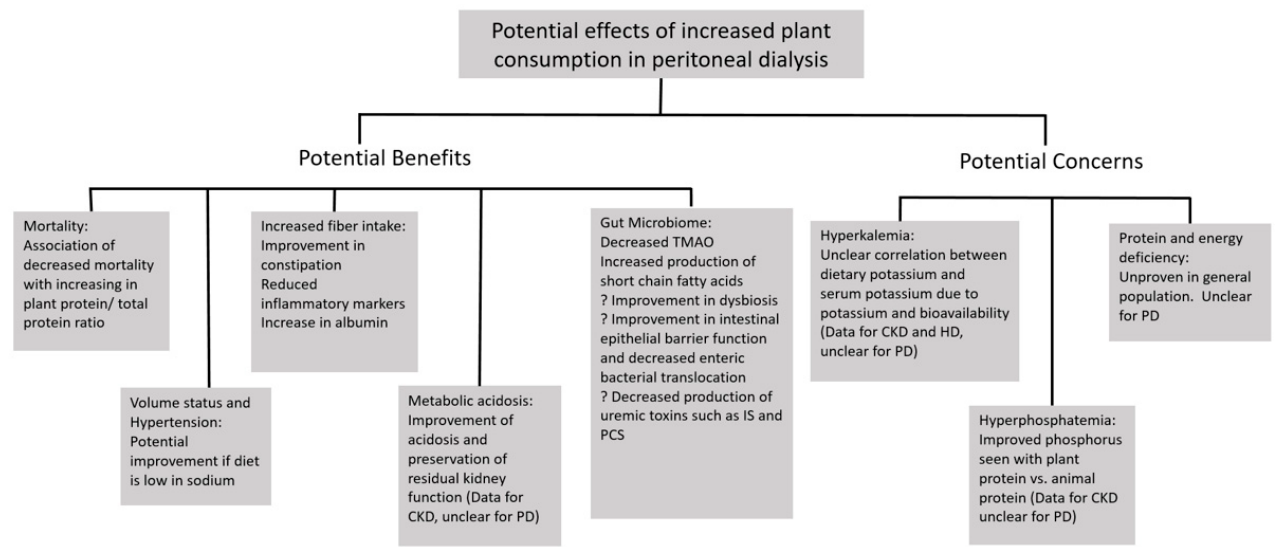
Figure 1. Potential benefits and concerns of increased plant consumption in peritoneal dialysis. CKD: Chronic kidney disease, PD: Peritoneal dialysis, HD: hemodialysis, TMAO: trimethylamine-N-oxide, IS: indoxyl sulfate, and PCS: p-cresol/p-cresyl sulfate.